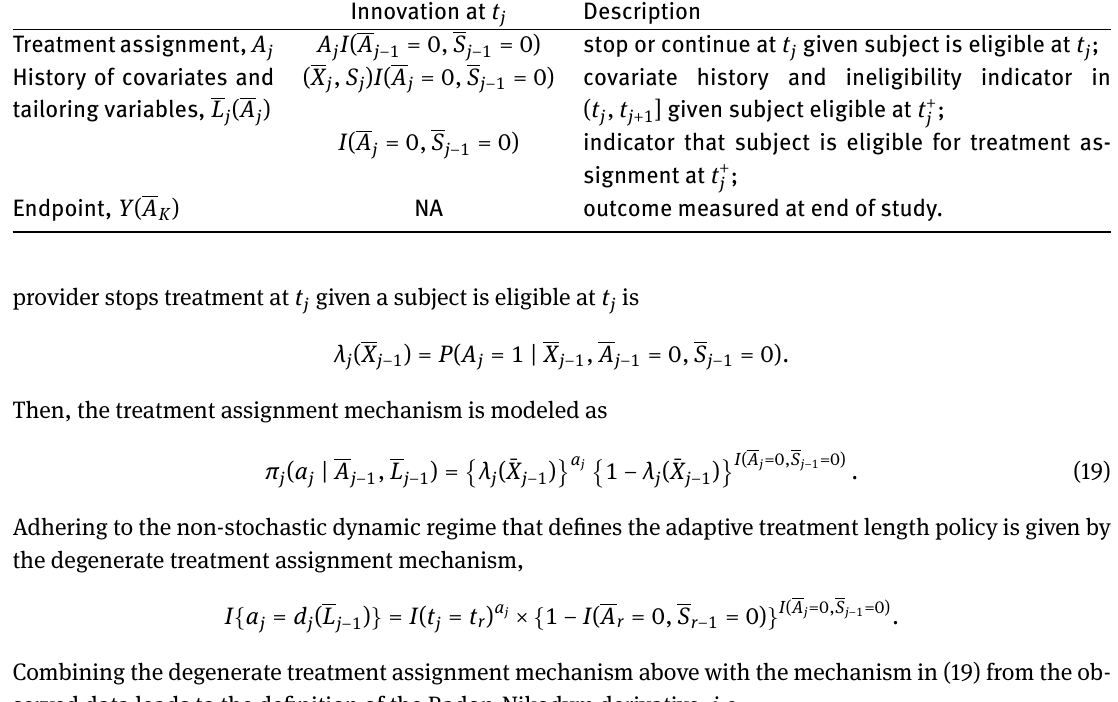
Table 1: The observed data in adaptive treatment length studies. Time t +